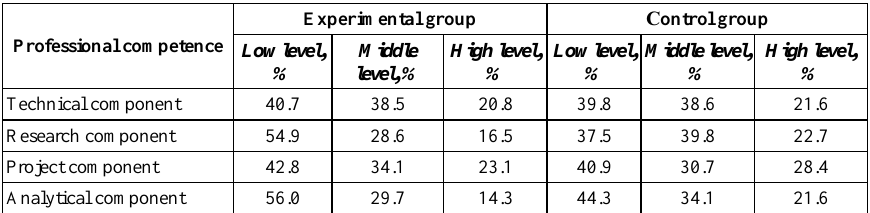
Table 1. Level of professional competence in the experimental and control groups at the beginning of the experiment Experimental group